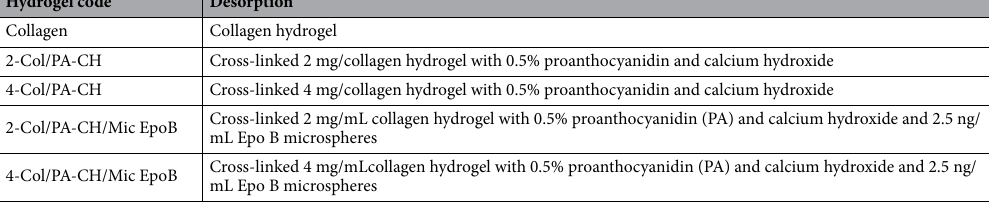
Table 2. The code used for different hydrogels prepared through thermal and chemical